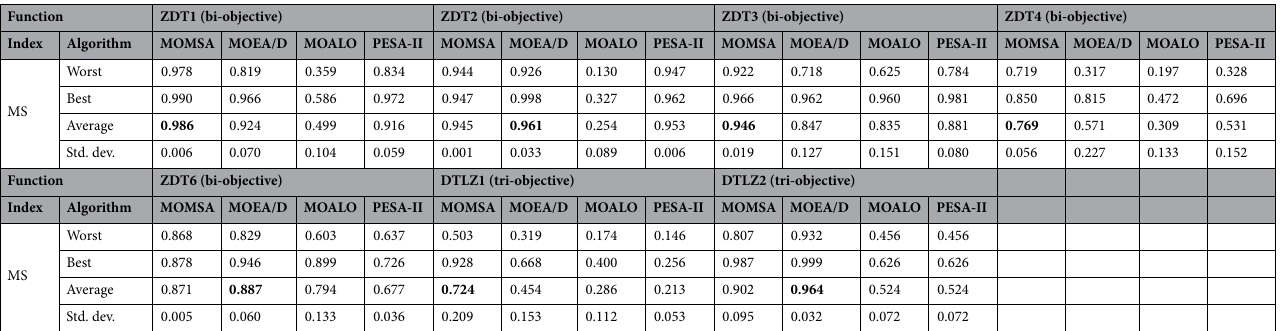
Table 8. Statistical results for MS evaluation metrics on ZDT bi-objective and DTLZ tri-objective test function suite. The bold values in the table represnt the best values obtained by the utilized algorithms for each benchmark